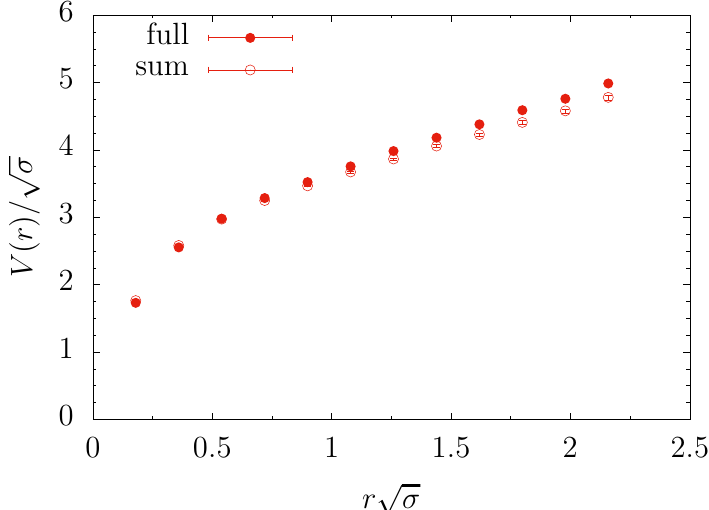
Figure 3. Comparison of the nonabelian static potential V ( r ) (filled symbols) with the sum of the monopole and modified potentials V sum ( r ) (empty symbols) for improved action at β = 3 .